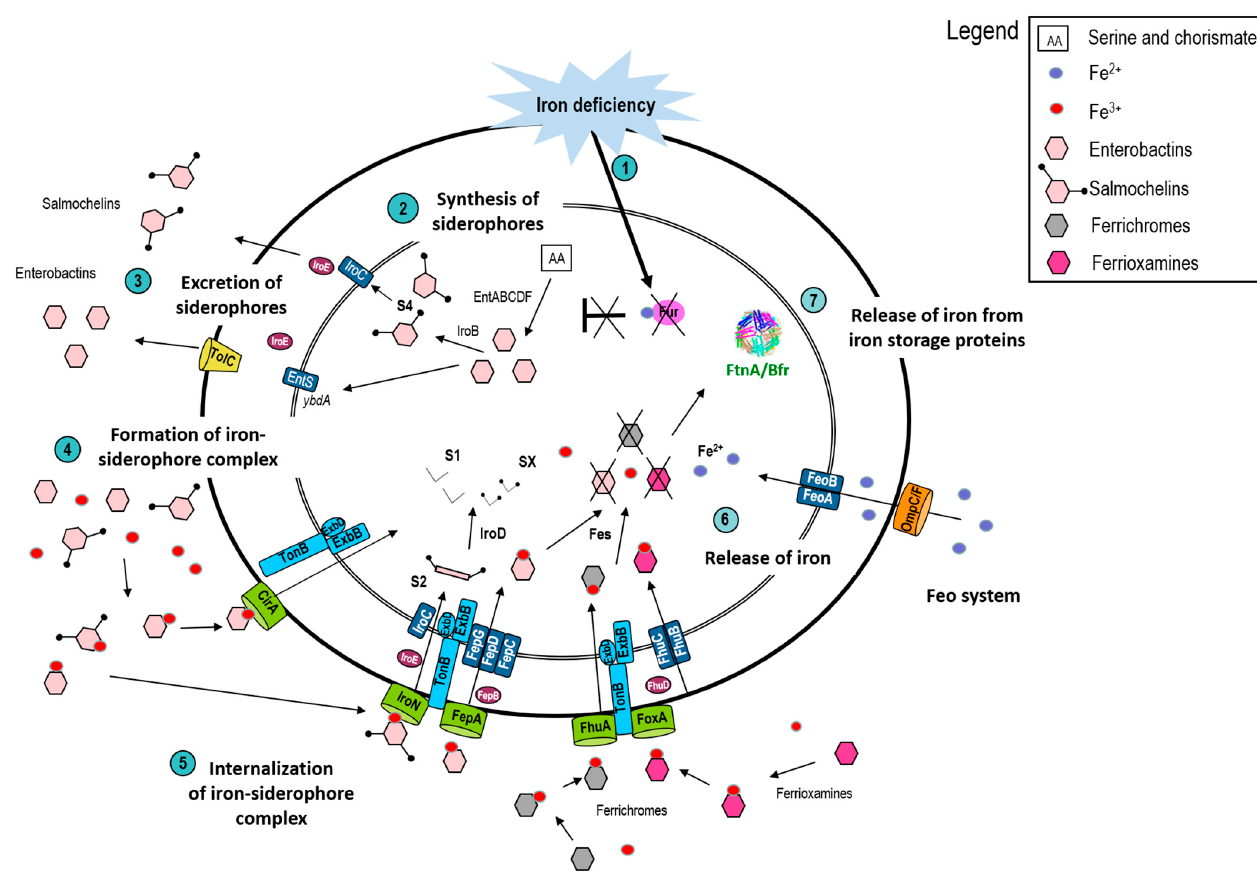
Figure 2. The different pathways of iron acquisition and storage in S . Enteritidis. (1) Iron deficiency induces derepression by the Fur regulator, leading to transcriptional upregulation of the genes under its control, in particular the genes encoding enzymes required for the production of siderophores. Salmonella is able to synthetize and/or use several siderophores: Enterobactin, salmochelin, ferrichrome, and ferrioxamine. (2) In the first step, enterobactin is synthetised using serine and chorismate as precursors. This step is catalysed by EntABCDF enzymes [62]. Then, enterobactin is transported into the environment by EntS and TolC or used as a precursor in the production of salmochelin S4 via the glycosyltransferase IroB [73]. (4) Once in the environment, the siderophores chelate ferric iron. (5) The siderophore-iron complexes (ferri-enteri- bactin and ferri-salmochelin, and the exogenous siderophores ferrichrome and ferrioxamine) are recognized by specific receptors present in the bacterial outer membrane (CirA and FepA for enterobactin, IroN for salmochelin, FhuA for ferri- chromes, and FoxA for ferrioxamine) [74]. Then, the TonB-ExbBD, an energy-transducing complex, drives siderophore internalization into the periplasm. Once in the cytoplasm, salmochelin is linearised into the S2 form by IroE, an esterase [68]. The passage through the inner membrane is achieved by the FepBDGC transporter for both salmochelin and entero- bactin [75,76]. On the other hand, ferrichromes and ferrioxamines use the FhuBCD transporter to pass through the inner membrane [77]. (6) Inside the cytoplasm, the iron-siderophore complexes are dissociated by esterases: Fes converts tricy- clic enterobactin into monomeric units; IroD act on the linear, trimeric S2 form of salmochelin [68] to generate mono (S1) or dimeric (SX) products from which iron can be released more readily. Finally, iron can be utilized for metabolism or (7) stored by ferritin (FtnA) or bacterioferritin (Bfr) [78]. To acquire Fe 2+ , S . Enteritidis primarily uses the FeoABC system [71,77], which allows iron to be imported across the inner membrane from the periplasm; the OmpC and OmpF porins allow passive diffusion of ferrous iron across the OM [79]. 3.3. Capacity of Siderophores to Capture Iron from Ovotransferrin By chelating iron, ovotransferrin leads to iron deficiency and to activation of high- affinity iron-acquisition systems. Studies on the impact of ovotransferrin-dependent iron restriction on the growth of E. coli and S . Enteritidis at 37 °C in Trypticase Soy Broth me- dium (TSB, pH 7) showed that ovotransferrin (5 g/L) induces expression of siderophore